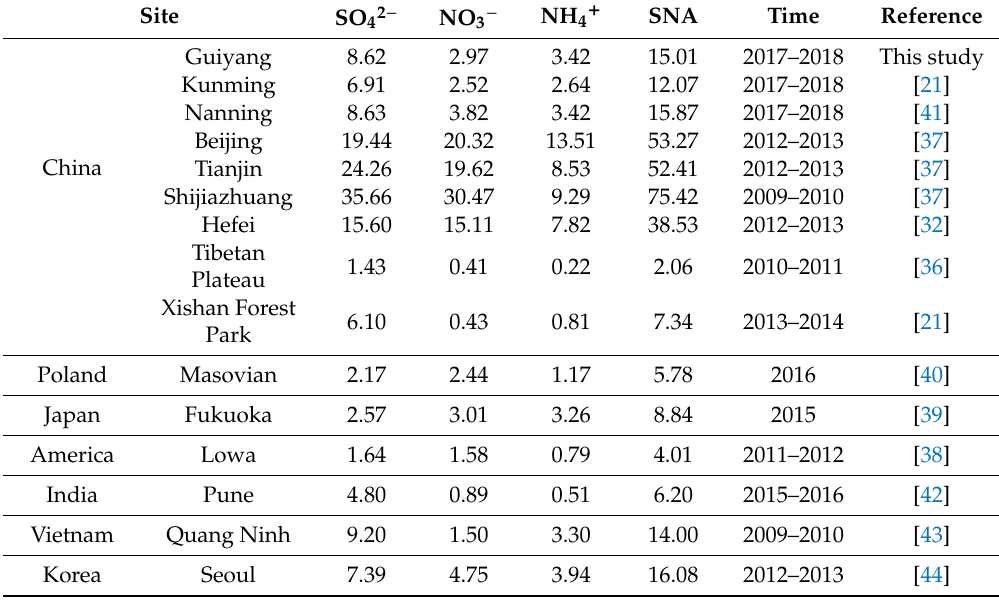
Table 2. SNA ( µ g m − 3 ) of PM2.5 in di ff erent cities (regions) over China and